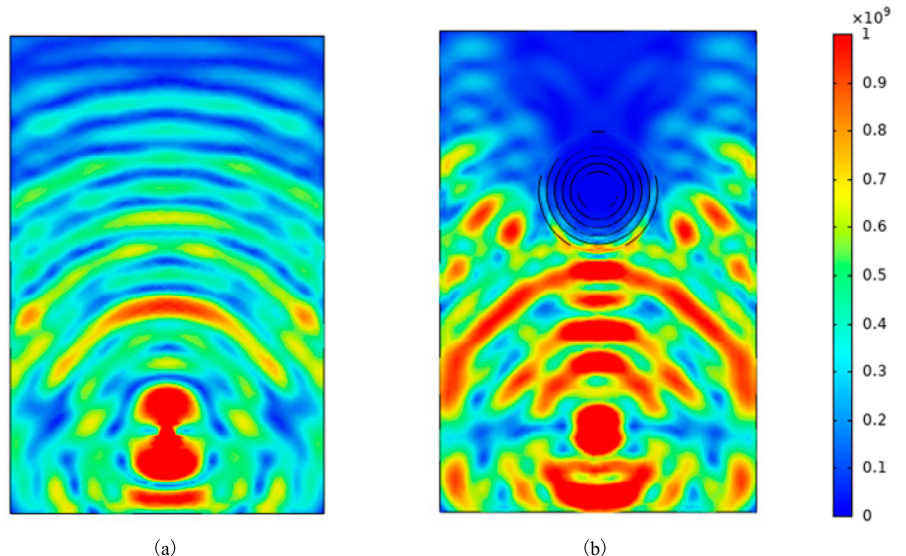
Figure 16. Von Mises stress distribution ( a ) without the metamaterial and ( b ) with the metamaterial.